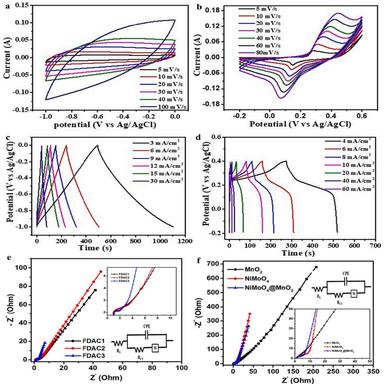
CV curves of FDAC3 (a), NiMoO4@MnO2 (b), GCD curves of FDAC3(c), NiMoO4@MnO2 (d), and EIS spectra of FDACs (e), and MnO2, NiMoO4 and NiMoO4@MnO2 (f).